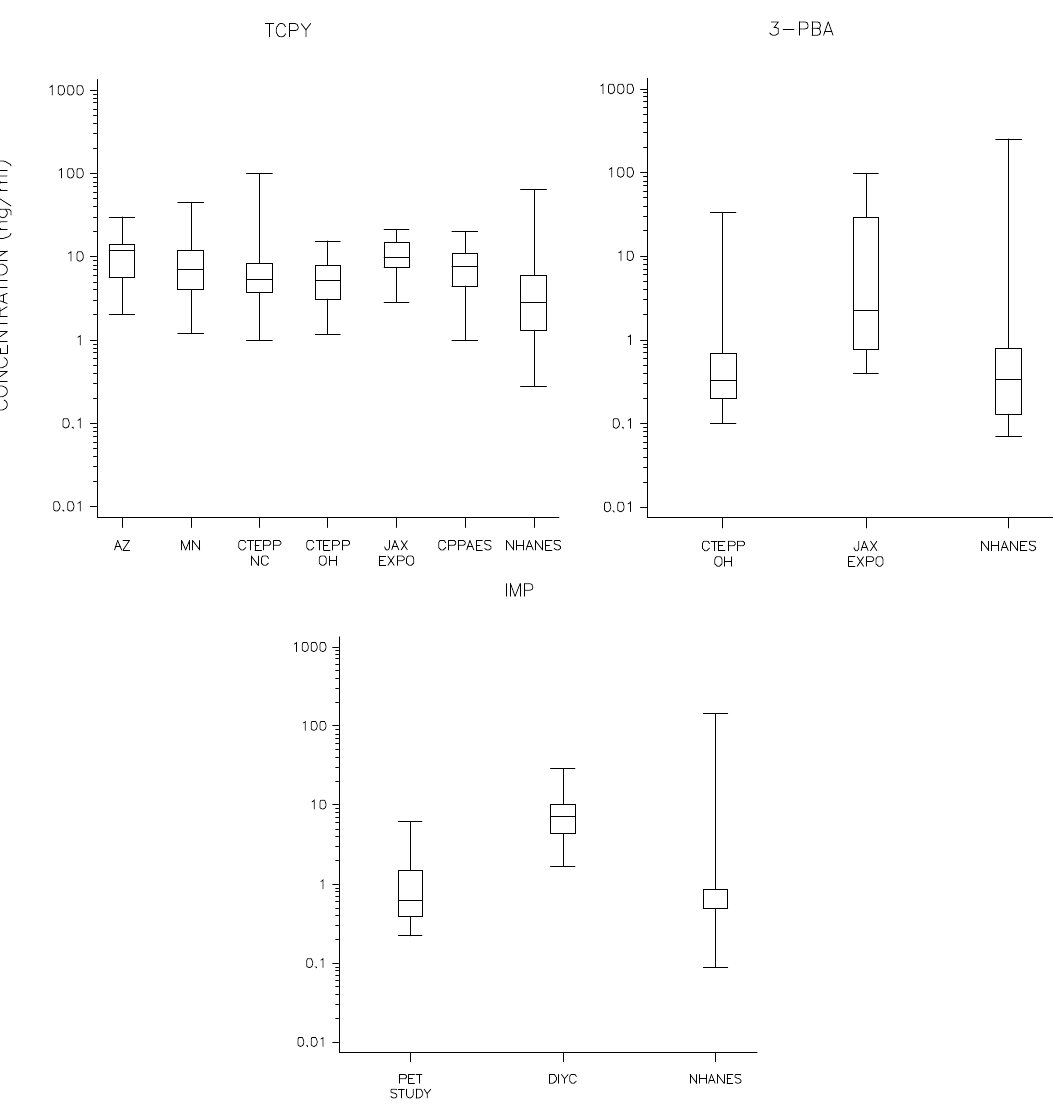
Figure 1. Box-and-whisker plots comparing the urinary TCPy, 3-PBA, and IMP concentrations across studies. NHANES results (6–12 year olds) included for